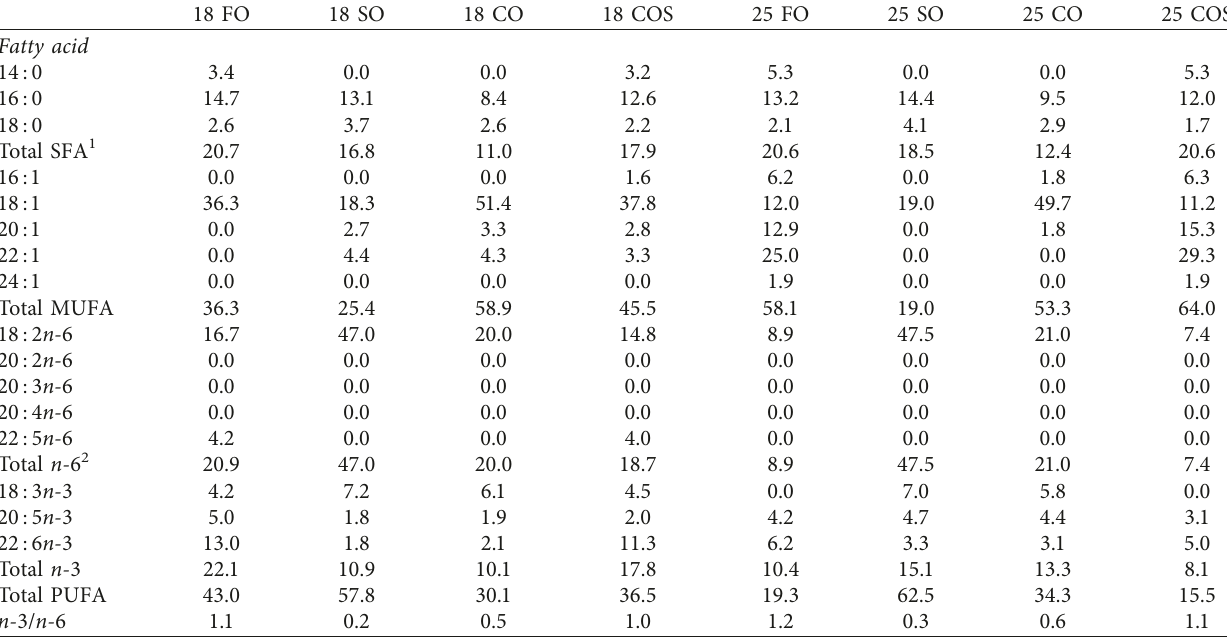
Table 2: Fatty acid profile of experimental diets (% of total fatty